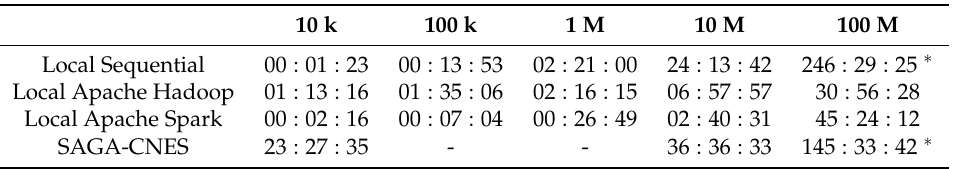
Table 3. Time measurements to study the scalability of the FastSOM algorithm using the proposed implementations